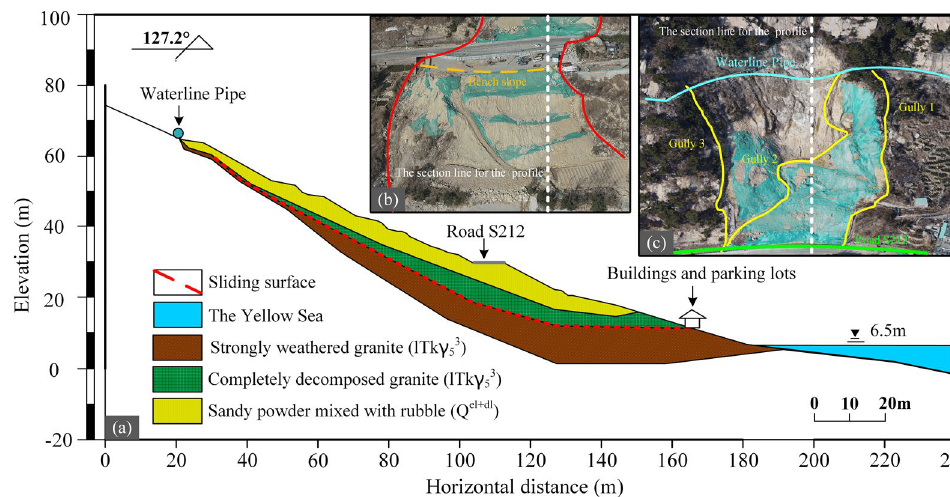
Fig. 3 a Schematic profile of landslide slope in 2020. b , c Overall view of